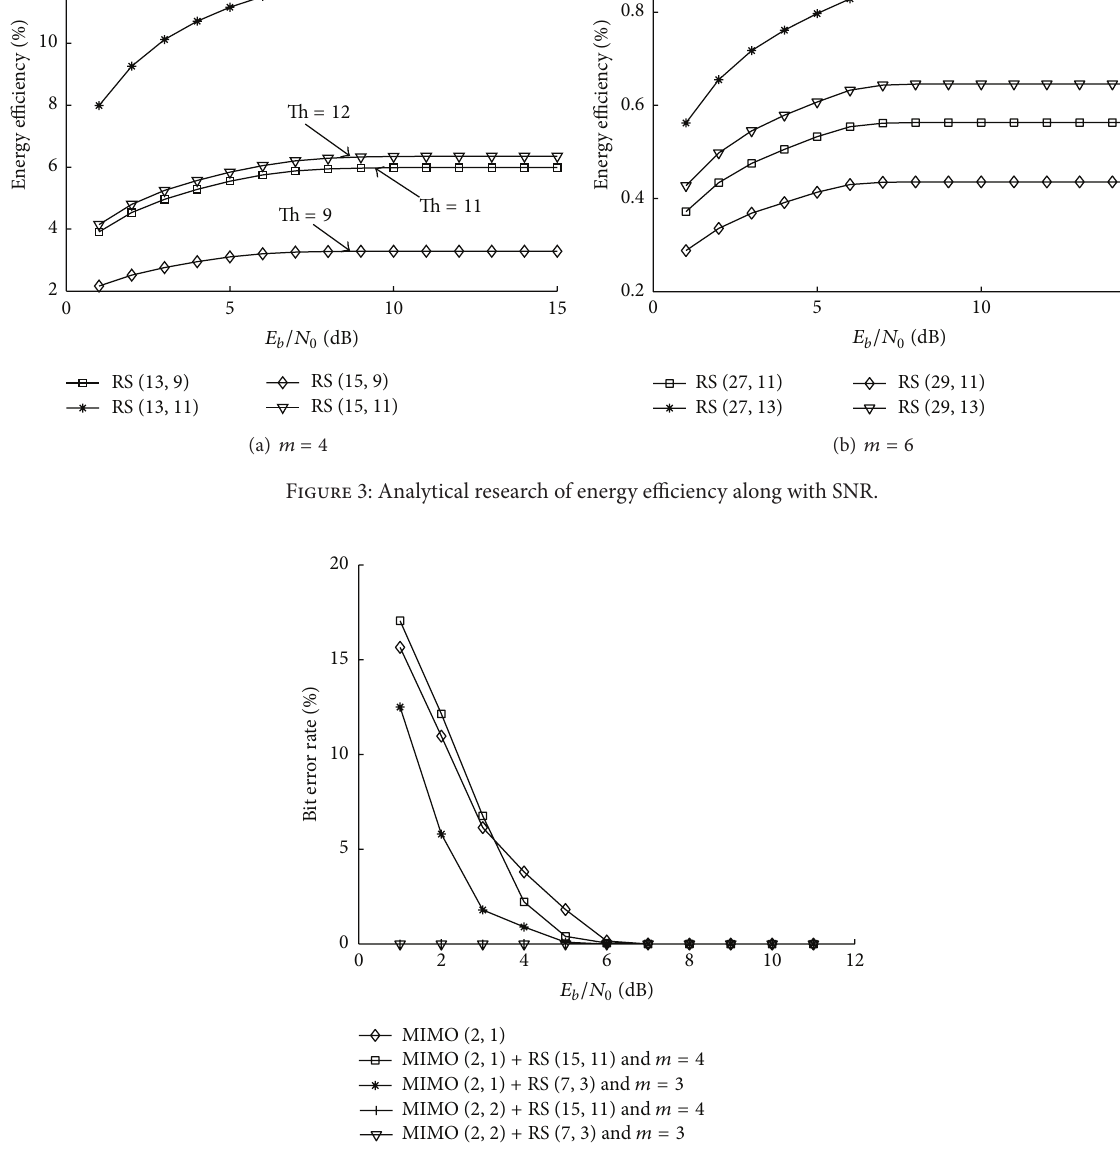
Figure 4: Performance comparisons between different combination scenarios of RS coder and MIMO